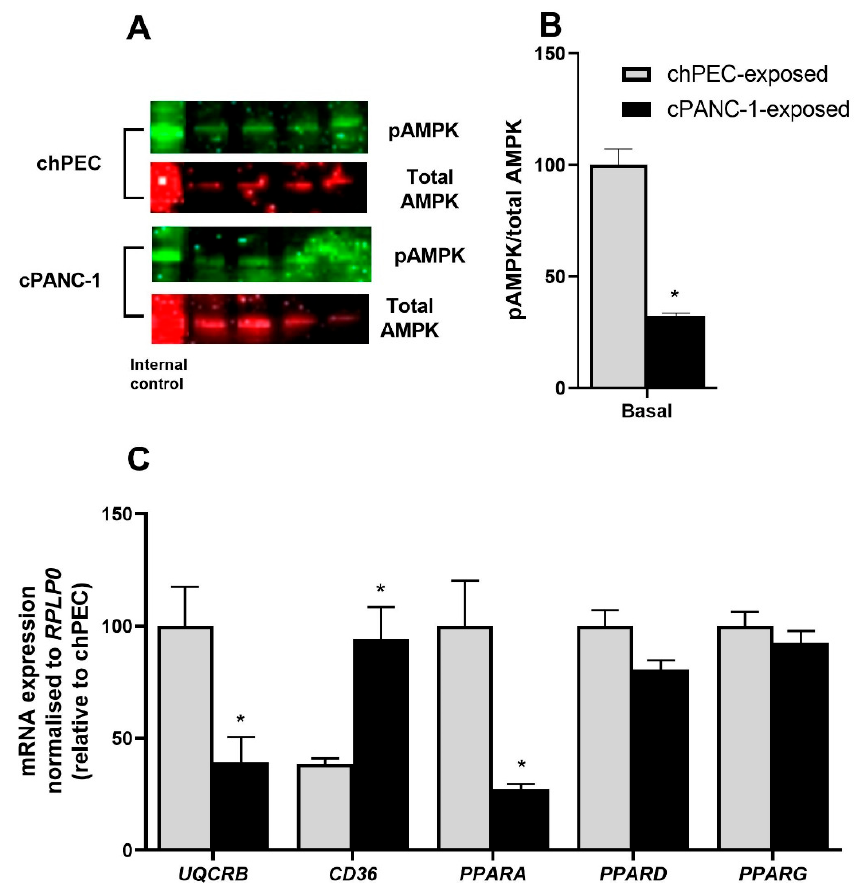
Figure 6. AMPK phosphorylation and gene expression in PANC-1- and hPEC-conditioned myotubes. In the last 4 days of differentiation, myotubes were conditioned with the medium from human primary pancreatic epithelial cells (chPEC exposed) or a pancreatic cancer cell line (cPANC-1 exposed). ( A ) Immunoblot showing AMPK phosphorylated on threonine 172 (pAMPK) and total AMPK. ( B ) Quantified immunoblots showing the pAMPK/total AMPK ratio adjusted to the internal control (HEK cells) and presented as a percentage of basal chPEC. ( C ) mRNA expression of ETC complex III ( UQCRB ), fatty acid transporter ( CD36 ), and peroxisome proliferator-activated receptor alpha ( PPARA ), delta ( PPARD ) and gamma ( PPARG ). Data in ( B , C ) are from three individual experiments, each with two biological replicates, presented as the mean ± SEM ( n = 6). * Statistically significant in cPANC-1-exposed versus chPEC-exposed myotubes ( p ≤ 0.05, paired t -test). 3.5. Secretomes from hPECs and PANC-1 Cells Indicate Increased Secretion of Certain